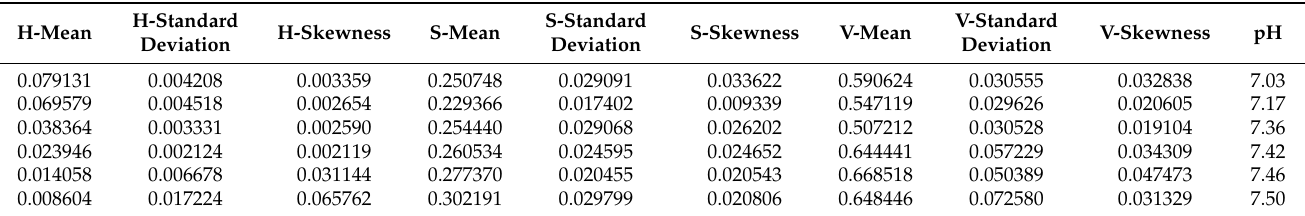
Table 2. Color moments in HSV color space and